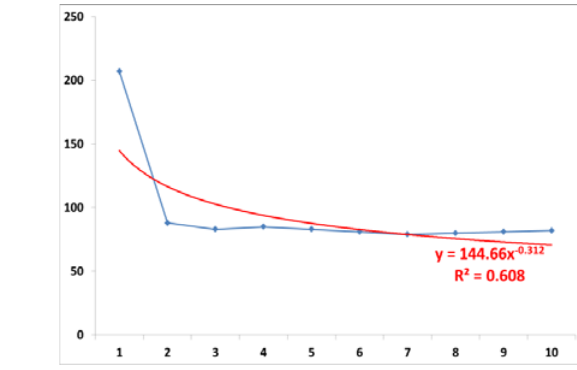
Fig. 15. Results of for Example 13 & 14 (50 variables) 𝐂𝐂 𝐦𝐦𝐦𝐦𝐦𝐦